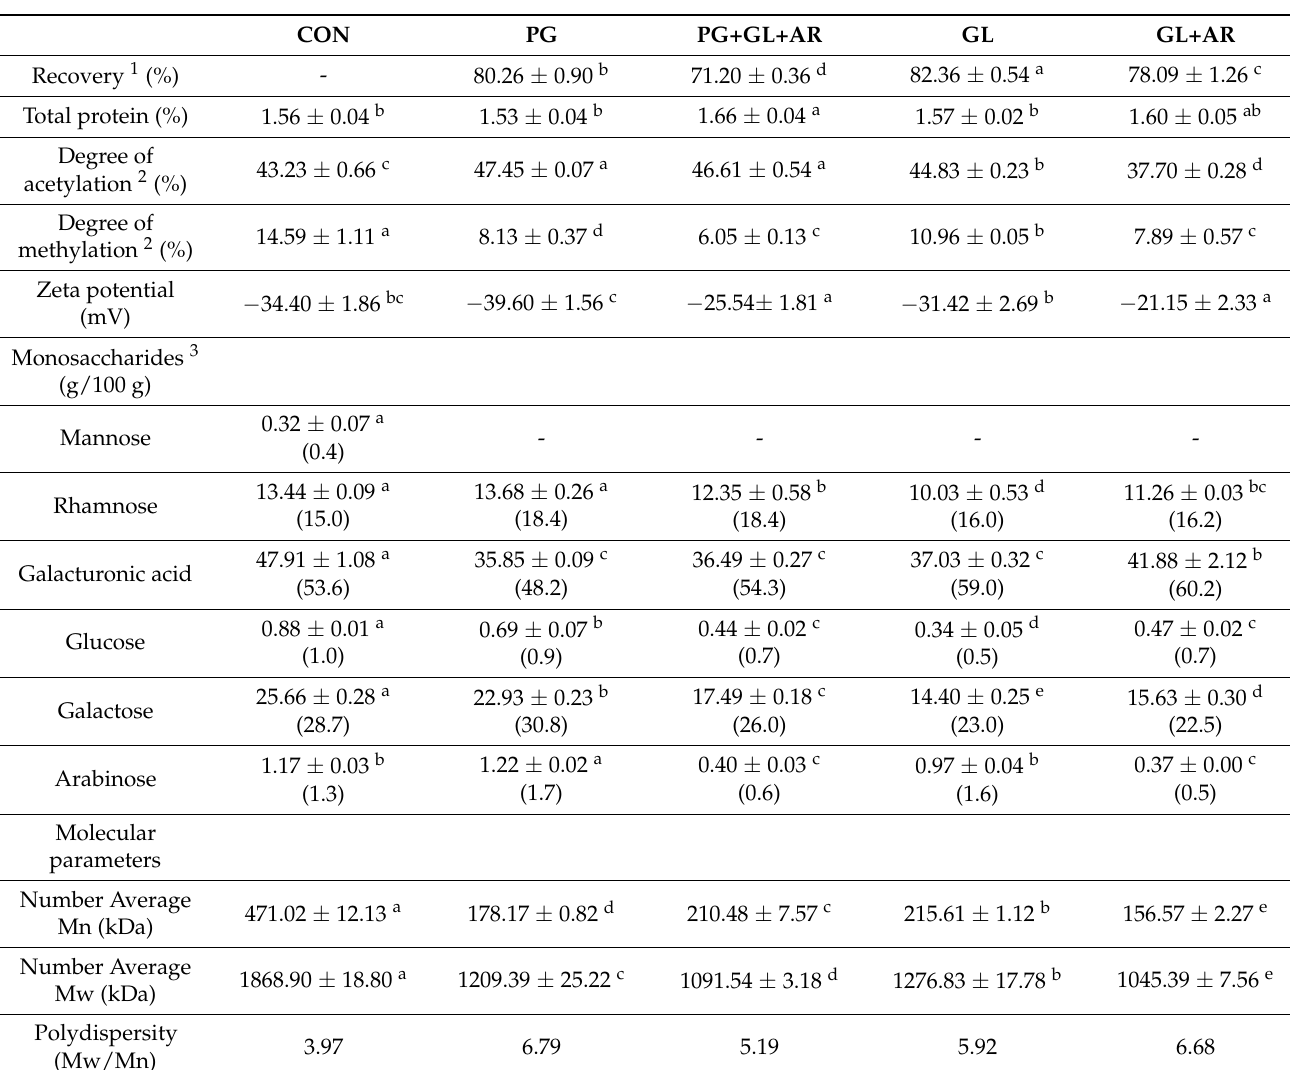
Table 2. Physicochemical properties and monosaccharide composition of OKPs following enzymatic hydrolysis 1,2